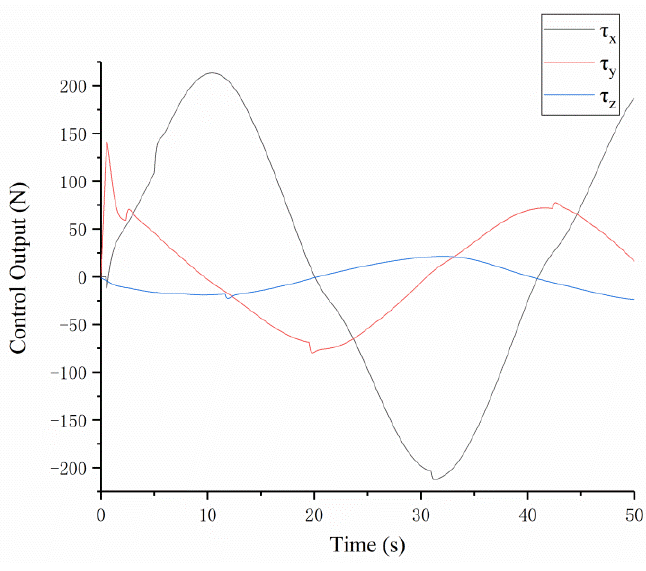
Figure 7. Control output of traditional